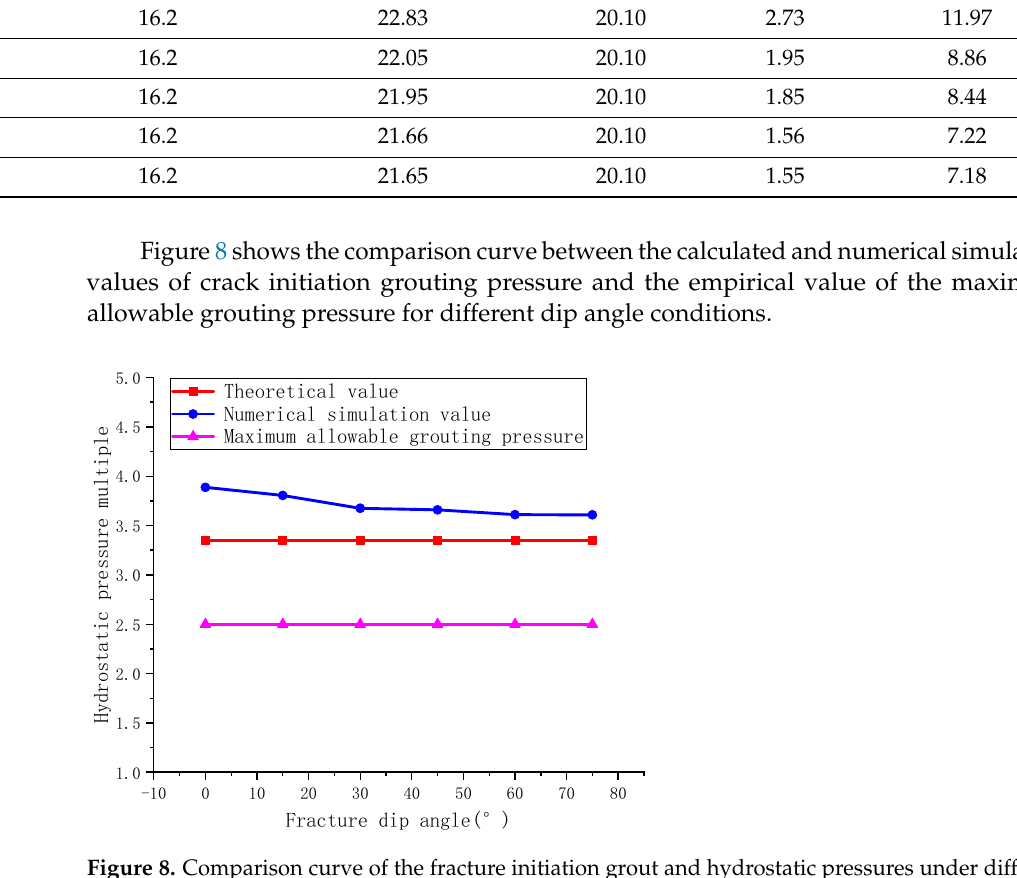
Figure 8. Comparison curve of the fracture initiation grout and hydrostatic pressures under different obliquity conditions.